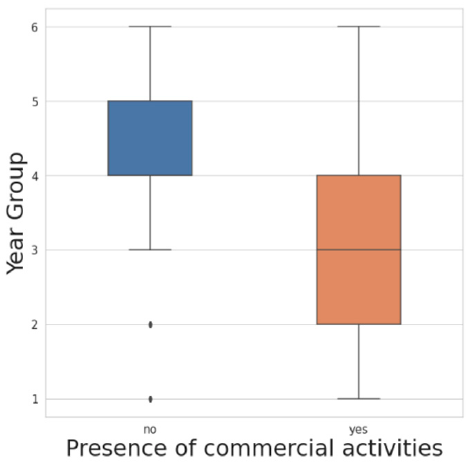
Figure 11. Distribution of maintenance interventions by the presence of commercial activities.